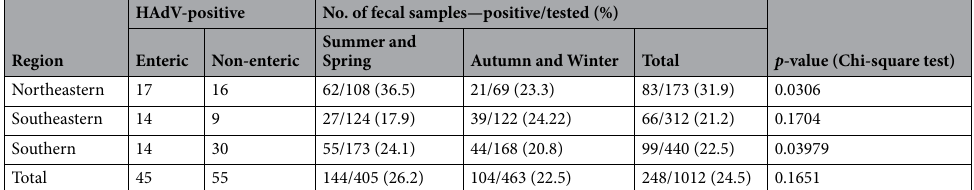
Table 2. Distribution of enteric and non-enteric HAdV types and seasonal distribution of HAdV-positive samples for each Brazilian region from 2018 to 2020.